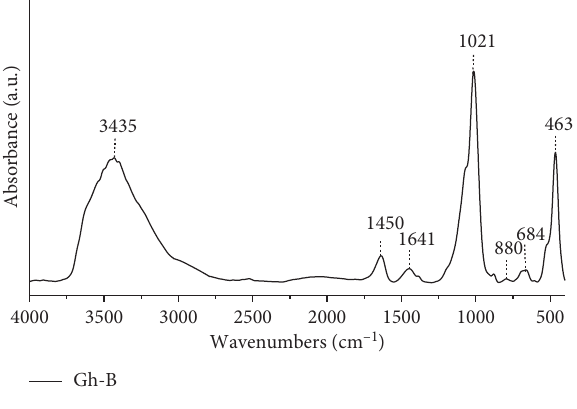
Figure 3: FTIR spectra of